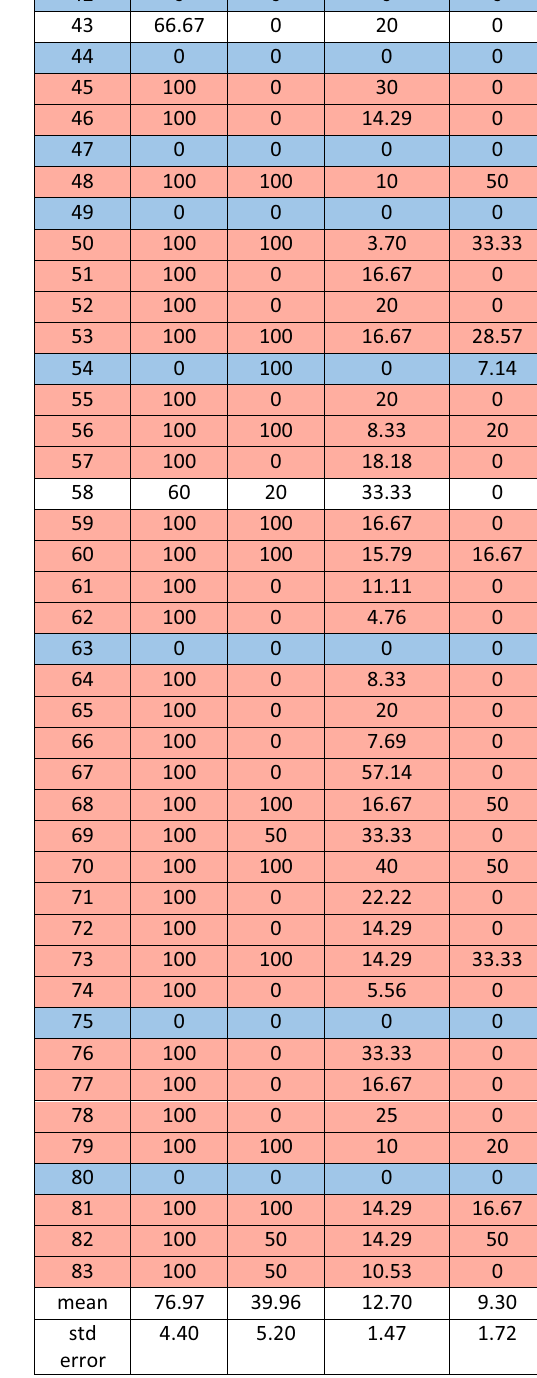
Table 2. Results of data analysis with SVM classifier: type of learning